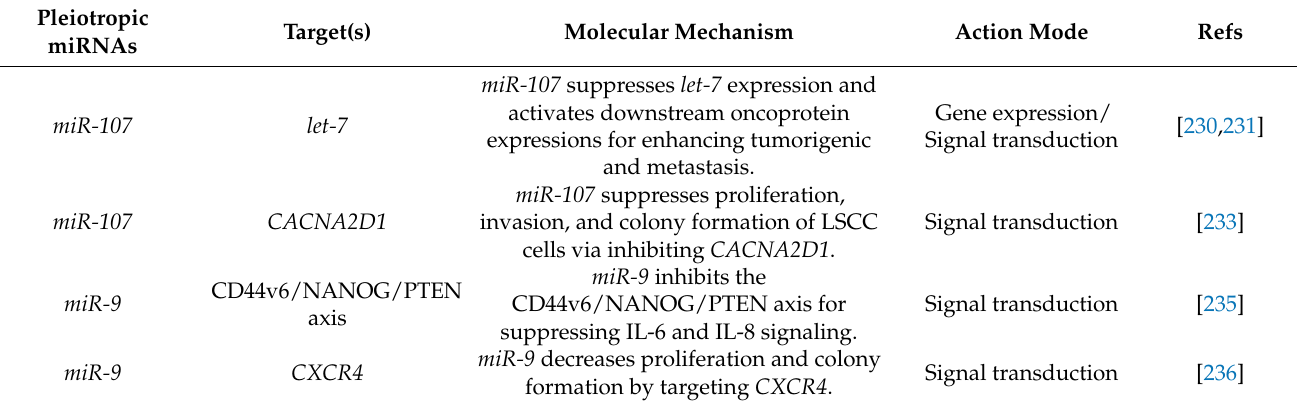
Table 3. miRNAs with pleiotropic functions that are involved in the stemness of head and neck squamous cell carcino- mas